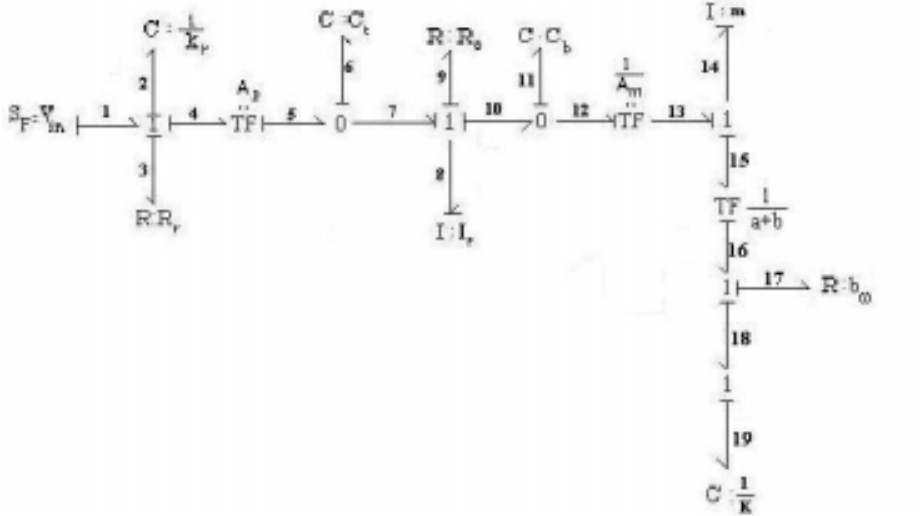
Fig. 9. Bond Graph Model of Fig.